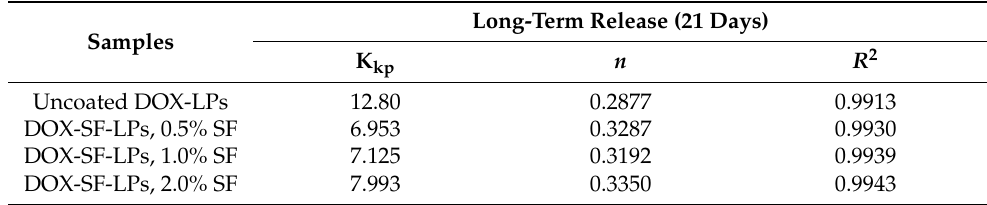
Table 2. Fitting parameters of drug release in SF-LPs using Korsmeyer–Peppas kinetic